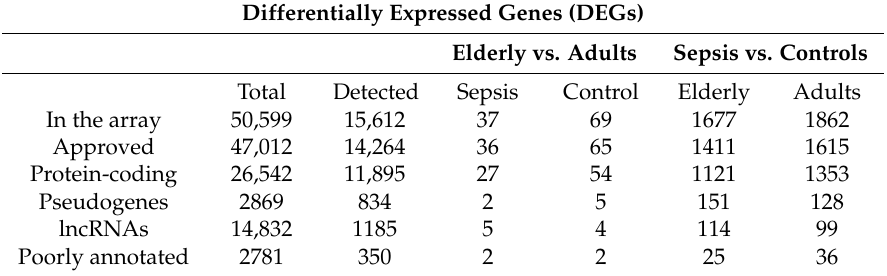
Table 1. Classification of array probes after the re-annotation procedure. Criteria for probe approval, detection and selection of differentially expressed genes ( p value ≤ 0.01) in each experimental group according to disease status or age are detailed in the Materials and Methods section. Differentially Expressed Genes (DEGs) Elderly vs. Adults Sepsis vs.